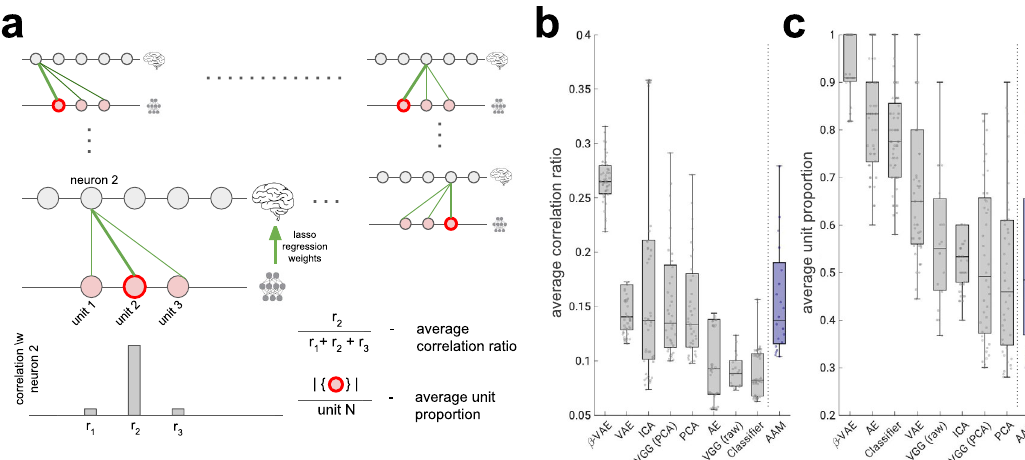
Fig. 5 Disentangled latent units have better diversity and one-to-one correlation with neurons compared to baselines. a Schematic of average correlation ratio and average unit proportion scores. A good computational model for explaining responses of single neurons should allow each neuron (grey circle) to be decodable from a single latent unit (pink circle). Green lines are Lasso regression weights as in Fig. 3a. The response of each neuron should correlate strongly with the response of only one latent unit (grey bars) as measured by the average correlation ratio (higher is better). Different neurons should correlate strongly with diverse single latent units (red circles) as measured by the average unit proportion score (higher is better). b Average correlation ratio scores are signi fi cantly higher for the β -VAE than the baseline models and the AAM model (all p < 0.01; AAM p = 3.4626 e – 07, ICA p = 4.3804 e – 07, VGG (PCA) p = 2.9275 e – 15, PCA p = 1.8577 e – 15, VAE p = 5.7259 e – 13, AE p = 8.2339 e – 16, Classi fi er p = 7.8206 e − 55, VGG (raw) p = 1.4072 e – 26, two-sided Welsch ’ s t -test). Circles, average correlation ratio score per model ( β -VAE, n = 51; VGG (raw), n = 22; Classi fi er, n = 64; VAE, Variational AutoEncoder 36 , n = 50; AE, AutoEncoder 35 , n = 50; VGG (PCA) 32 , n = 41; PCA, n = 41; ICA, n = 50; AAM, active appearance model 3 , n = 21). Boxplot centre is median, box extends to 25th and 75th percentiles, whiskers extend to the most extreme data that are not considered outliers, outliers are plotted individually. Source data are provided as a Source Data fi le. c Average unit proportion scores are signi fi cantly higher for the β -VAE than the baseline models and the AAM model (all p < 0.01; Classi fi er p = 4.5163 e – 10, AE p = 1.4289 e – 04, VAE p = 4.1792 e – 14, ICA p = 1.1129 e – 19, VGG (PCA) p = 1.7441 e – 19, PCA p = 3.5554 e – 19, AAM p = 1.8075 e – 09, VGG (raw) p = 1.2049 e – 08, two-sided Welsch ’ s t -test). Circles, average unit proportion score per model ( β -VAE, n = 51; VGG (raw), n = 22; Classi fi er, n = 64; VAE 36 , n = 50; AE 35 , n = 50; VGG (PCA) 32 , n = 41; PCA, n = 41; ICA, n = 50; AAM 3 , n = 21). Boxplot centre is median, box extends to 25th and 75th percentiles, whiskers extend to the most extreme data that are not considered outliers, outliers are plotted individually. Source data are provided as a Source Data fi